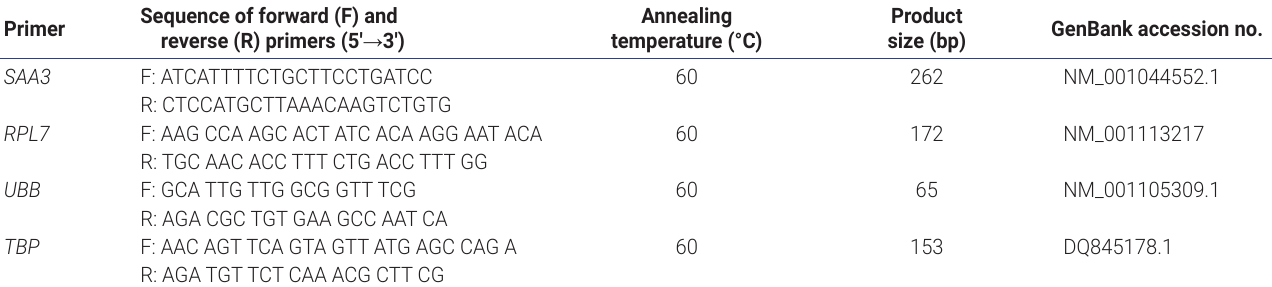
Table 1. Summary of primer sequences for real-time RT-PCR, RT-PCR, and in situ hybridization and expected product size Sequence of forward (F) and Primer reverse (R) primers (5' →